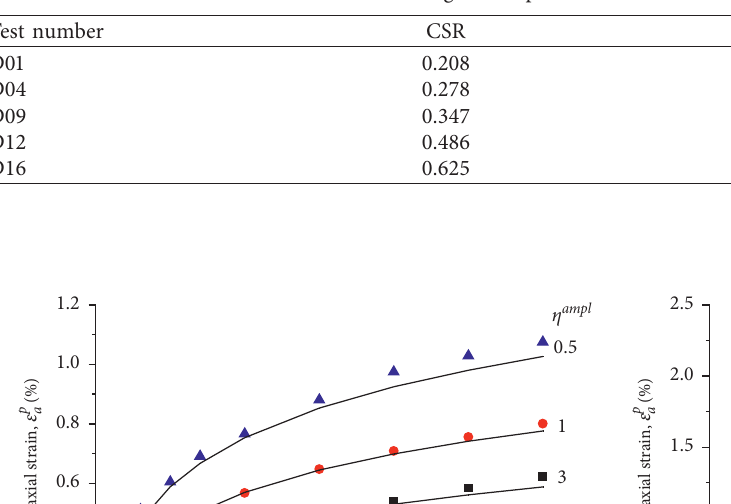
Figure 16: Development of permanent axial strain with increasing cycle numbers in CCP tests. η ampl � 3. Table 3: Regression parameters C 1 and C 2 in equation (4).